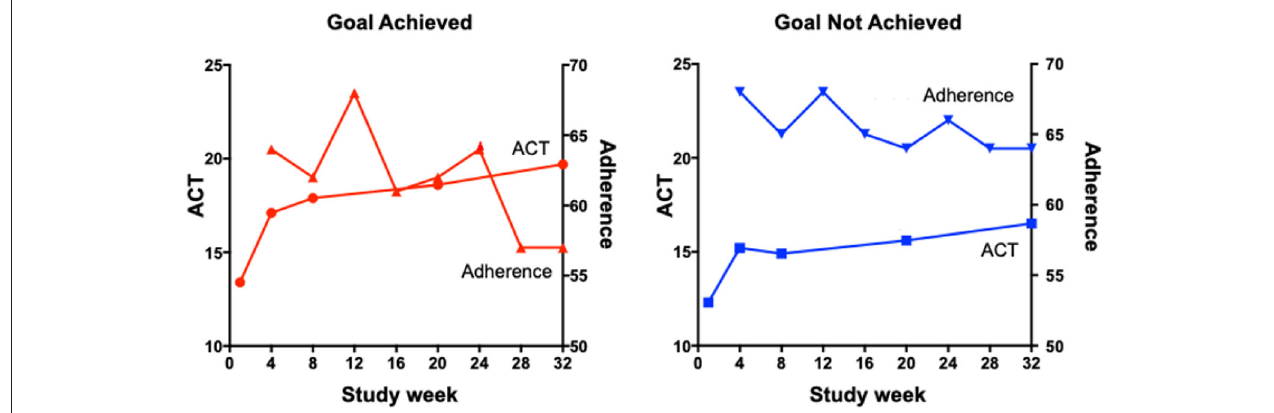
FIGURE 1 | The relationship between ACT scores and adherence in participants who did or did not achieve their goals.